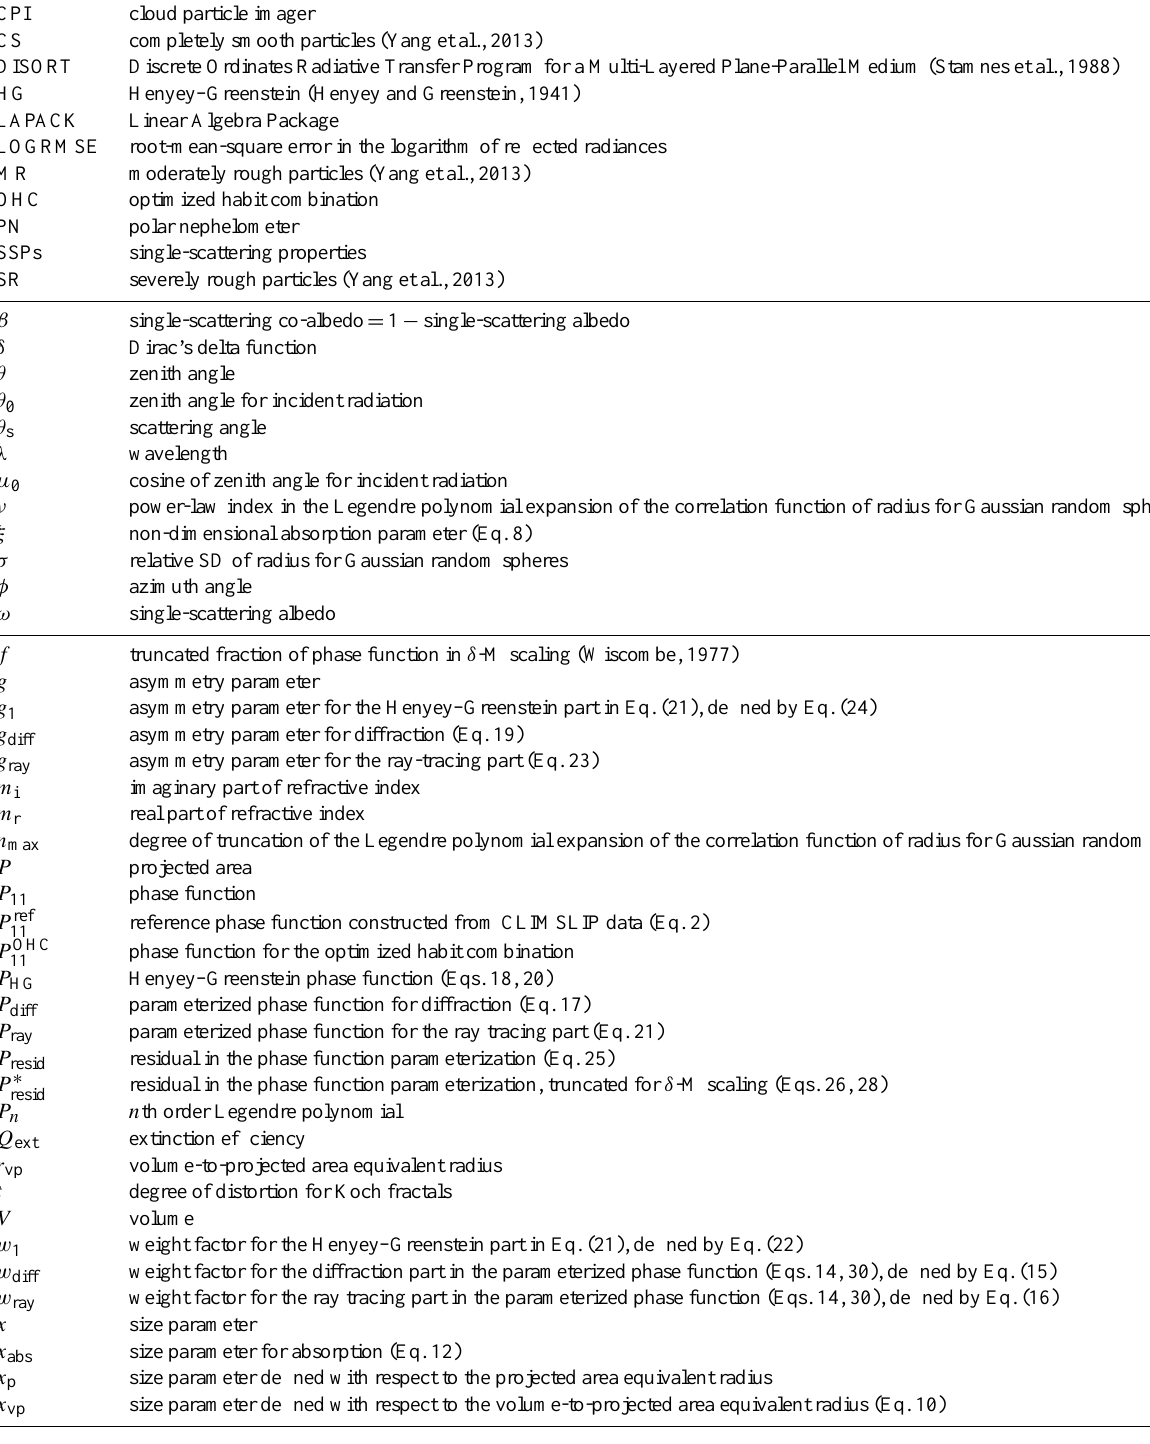
Table A1. List of abbreviations and symbols.